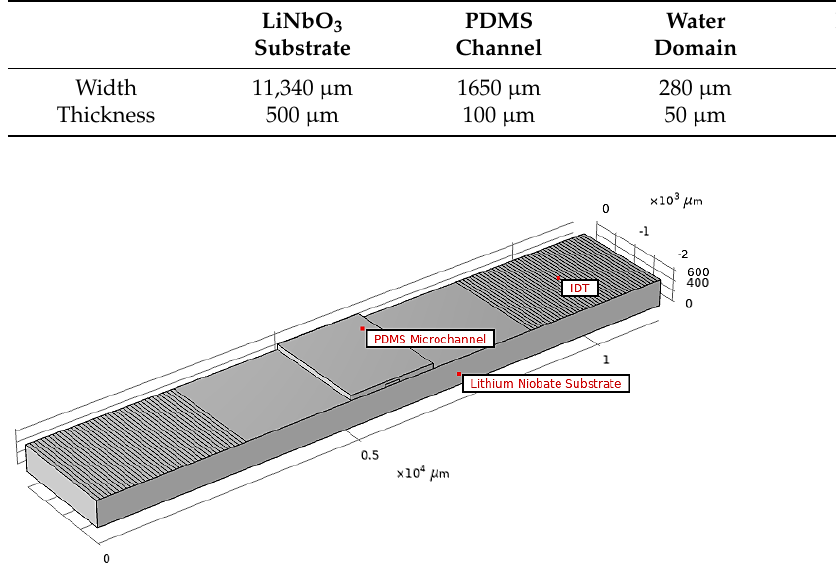
Table 1. Dimensions of the SAW-based device components.